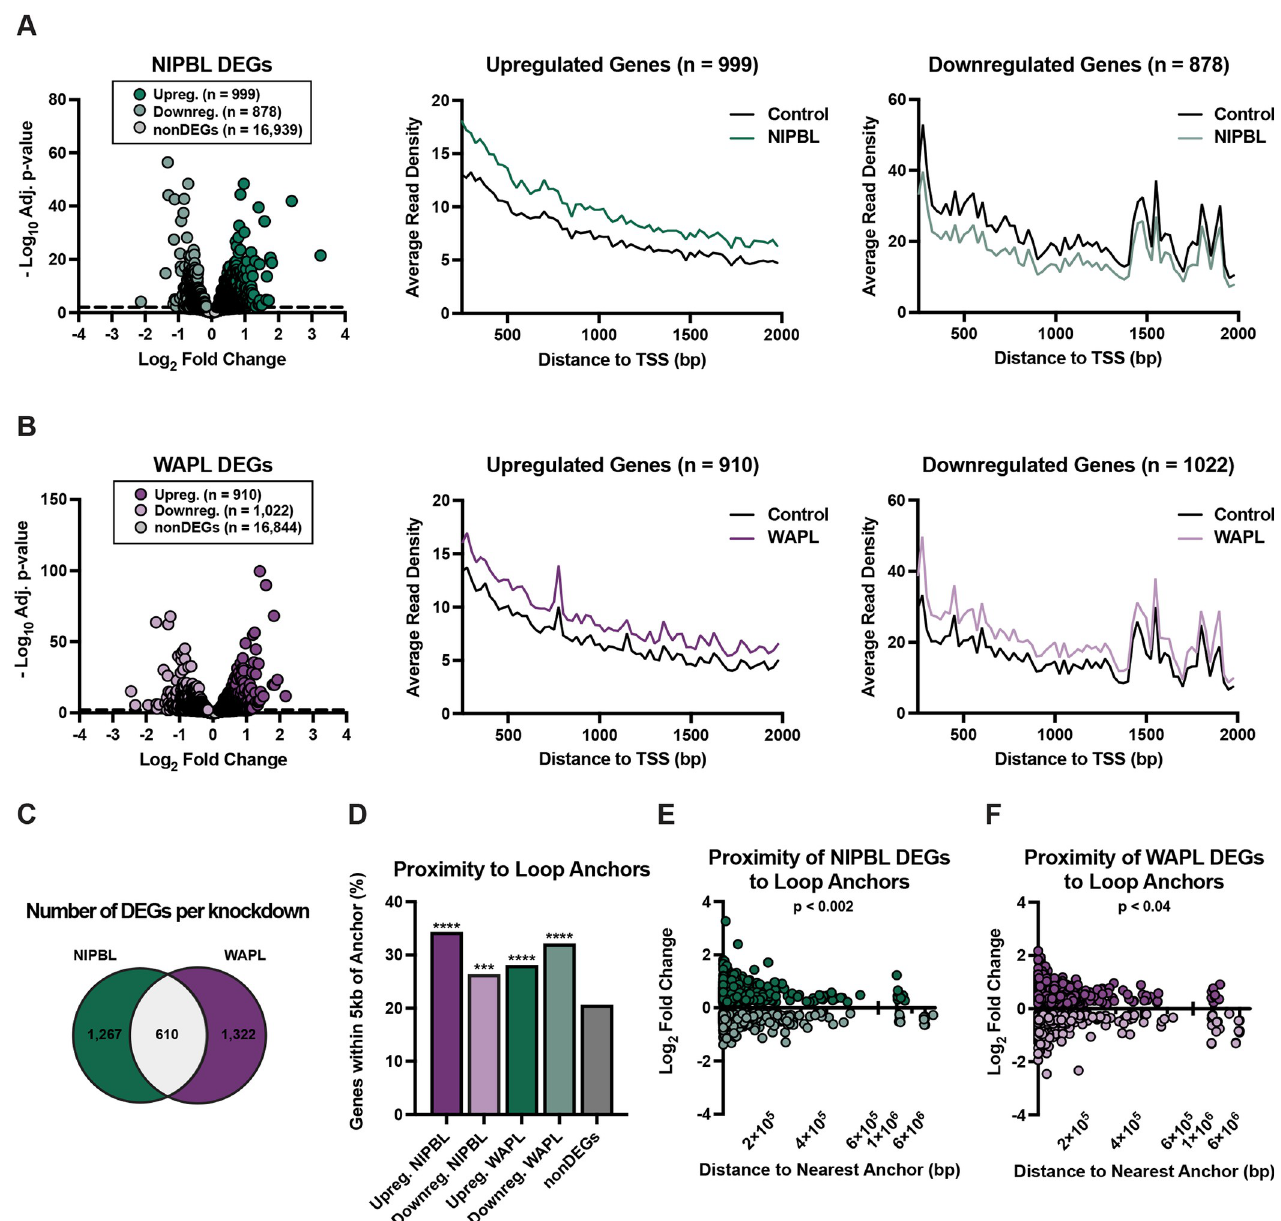
Fig 2. NIPBL and WAPL regulate the expression of unique and shared sets of genes. (A) The log 2 (fold change) of genes after NIPBL knockdown versus their significance. DEGs are in green (999 up, 878 down) and non-significantly changed genes (nonDEGs, adjusted p-value > 0.01) are in grey. Average read density over genes from transcriptional start site (TSS) upregulated (middle) or downregulated (right) after NIPBL knockdown. (B) The log 2 (fold change) of genes after WAPL knockdown versus their significance. DEGs are in purple (910 up, 1022 down) and nonDEGs (adjusted p-value > 0.01) are in grey. Average read density over genes from TSS upregulated (middle) or downregulated (right) after WAPL knockdown. (C) Venn diagram of the number of NIPBL, WAPL, and shared DEGs. (D) Percentage of up, down, NIPBL, WAPL, or nonDEGs with a TSS within 5kb of a loop anchor. Fisher’s exact test compared to nonDEGs, ���� p < 0.0001, ��� p = 0.0002. (E) Distance from each NIPBL DEG TSS to the nearest loop anchor versus the fold change of the gene. Spearman correlation, p = 0.0018. (F) Distance from each WAPL DEG TSS to the nearest loop anchor versus the fold change of the gene. Spearman correlation, p = 0.037.